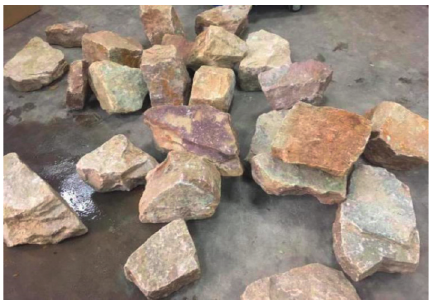
Figure 5: Quartz sandstone